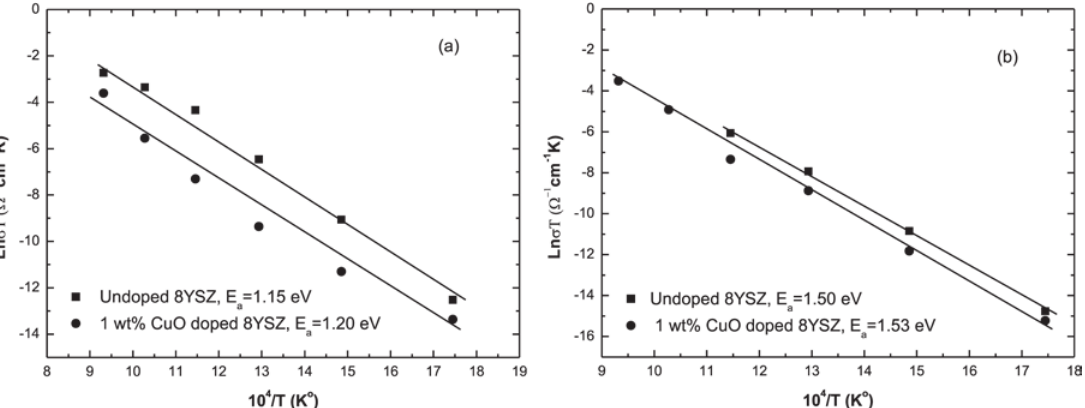
Fig. 7: Activation energies for undoped and 1 wt% CuO-doped 8YSZ specimens sintered at 1400 °C for 10 h. a) Grain interior and b) Grain